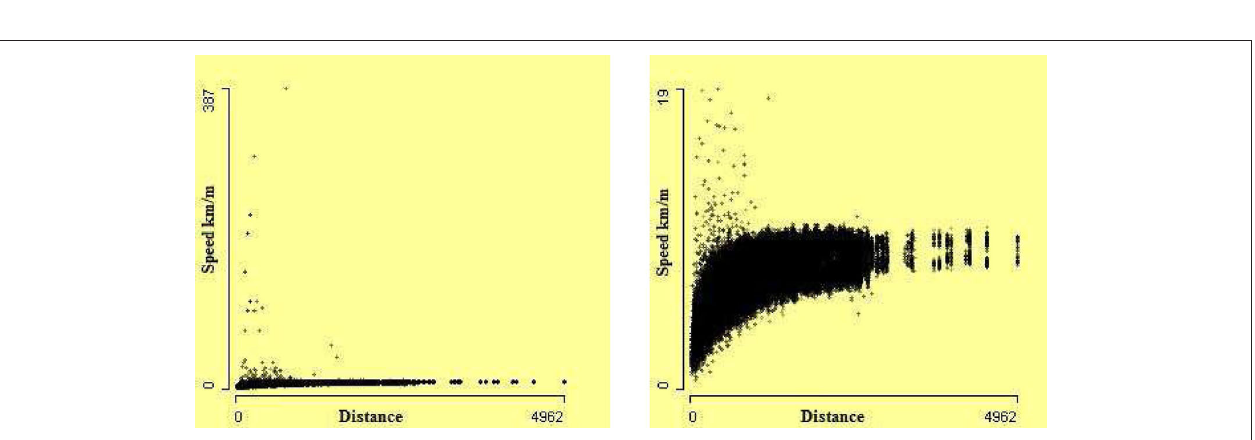
FIgurE 6 | Scatterplots of speed against distance. On the left, all 969,304 cases. On the right, after removing 150 extreme outliers, using